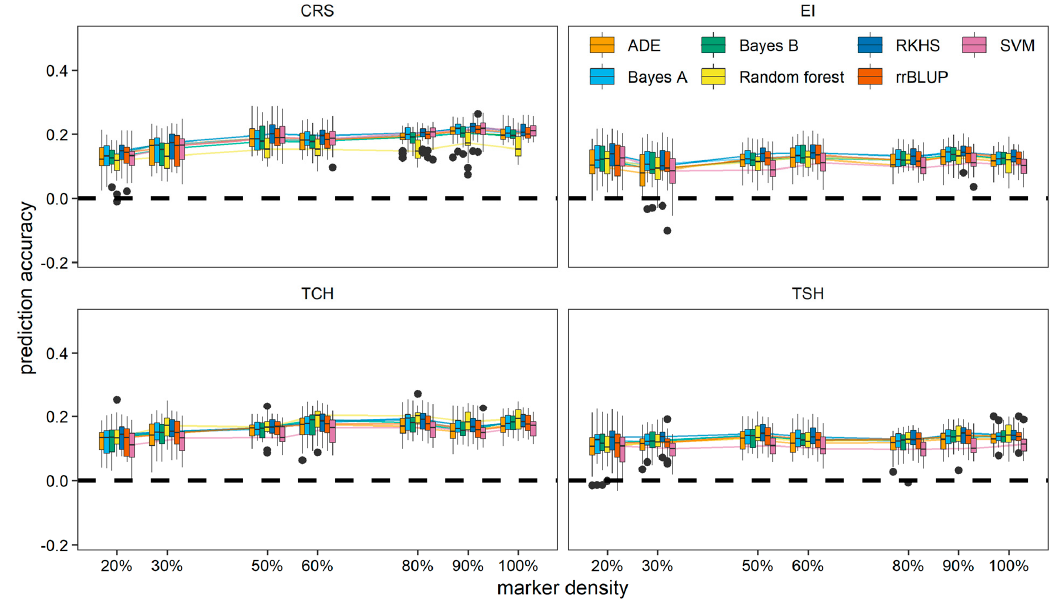
Figure 6. Fivefold cross-validated prediction ability for four secondary traits: commercial recovera- ble sugar (CRS), economic index (EI), ton cane per hectare (TCH), and ton sugar per hectare (TSH) in sugarcane based on seven different genomic selection models and marker density. The plant cane phenotypic data were used.